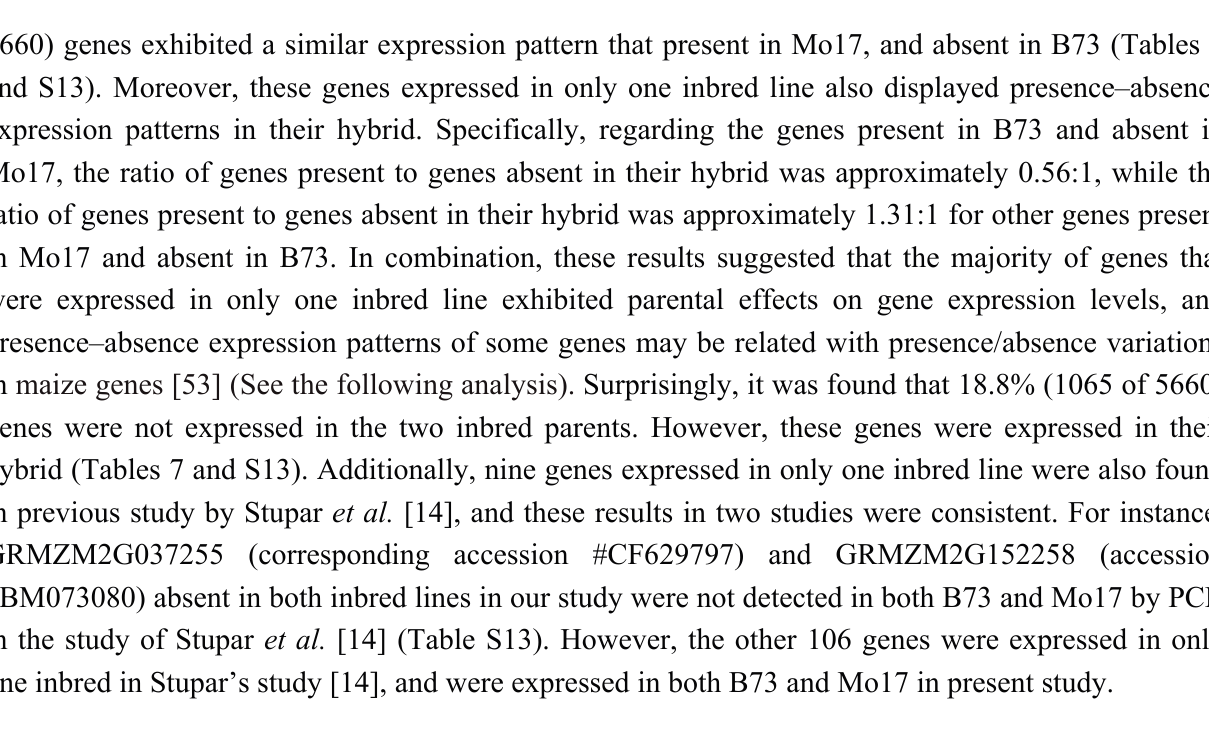
Table 7. Genes with no detectable expression in one inbred line or both two inbred lines.